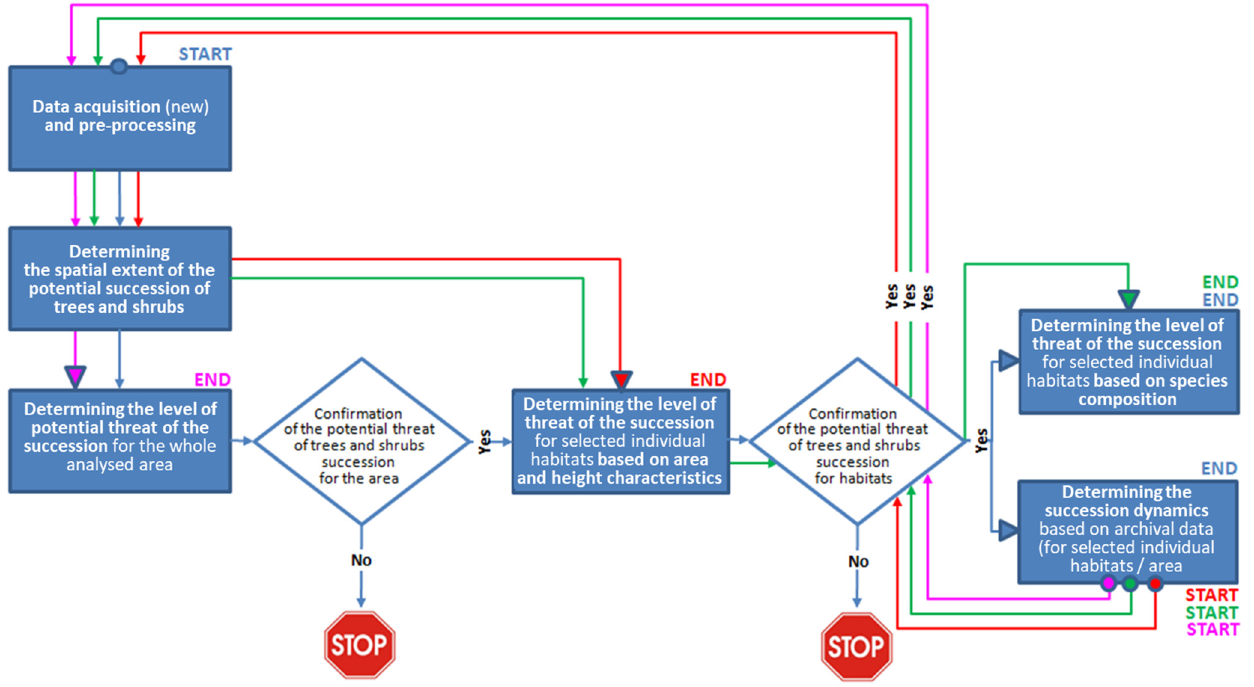
Figure 9. The possible approaches to execution of the